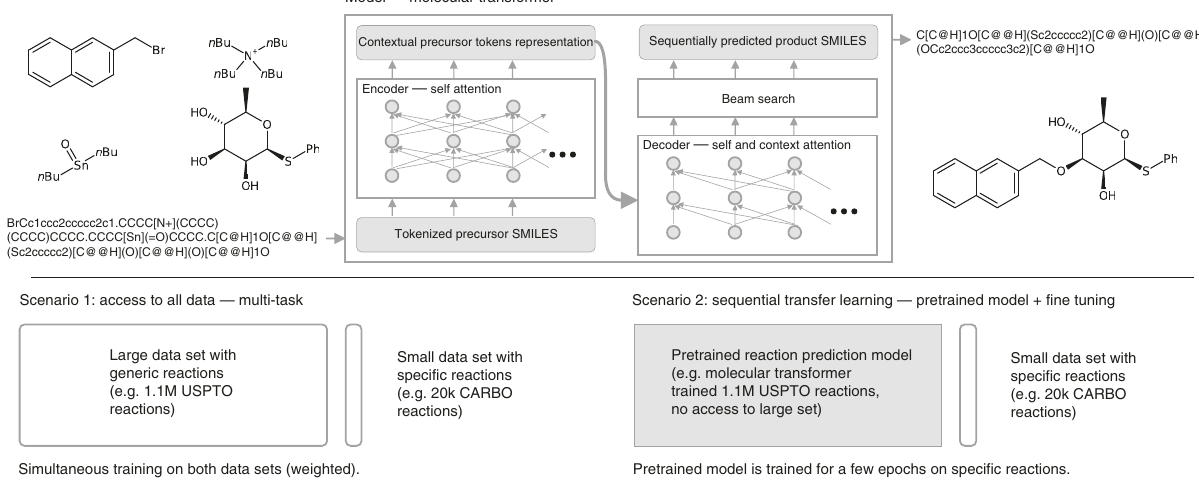
2: sequential transfer learning — pretrained model + fine tuning